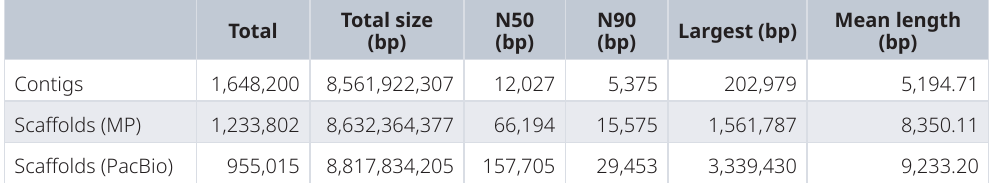
Table 1. Results of the assembly for the desert locust